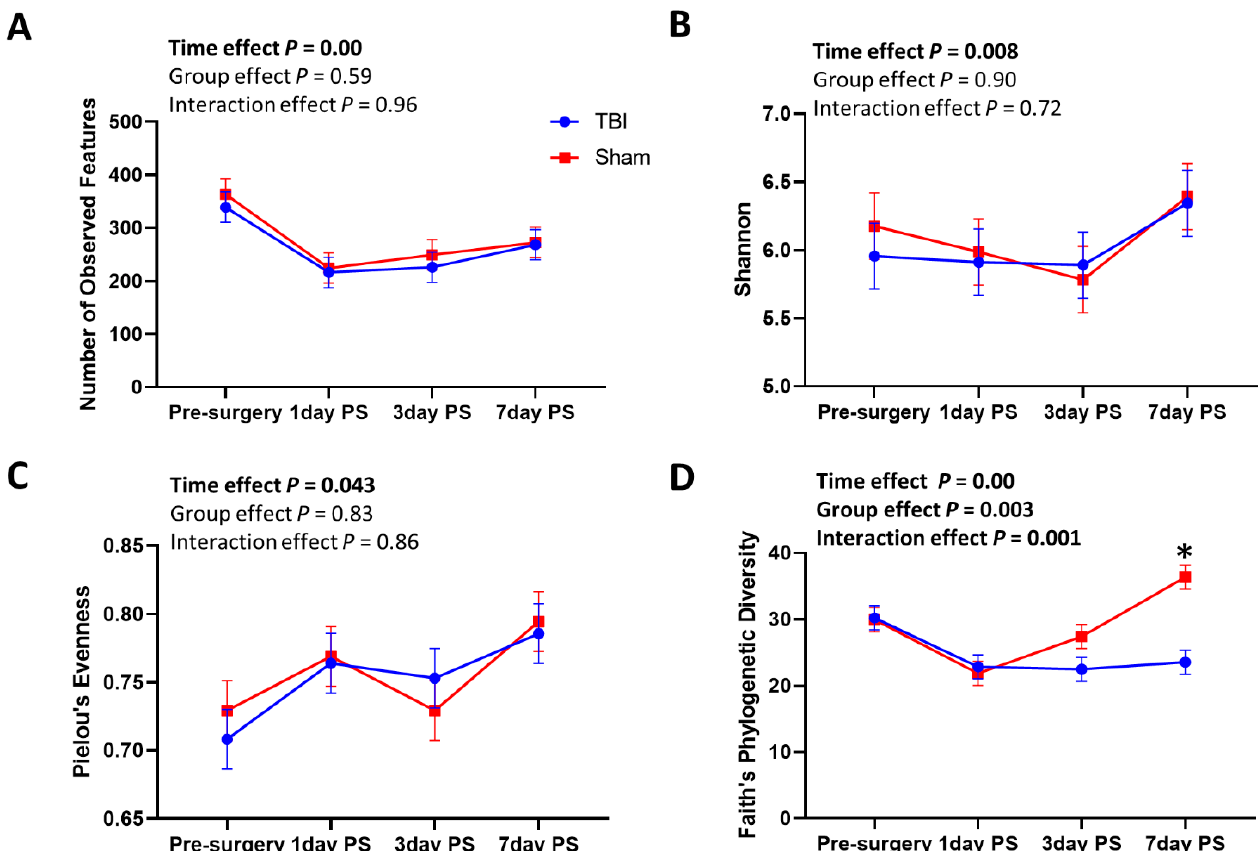
Figure 1. TBI did not significantly alter alpha diversity indexes of the oral microbiome except for Faith’s phylogenetic diversity. Alpha diversity indexes were measured by the number of observed features, Shannon, Pielou’s evenness, and Faith’s phylogenetic diversity. ( A – D ) Significant time effects were found in all alpha diversity indexes, while no group or time-by-group interaction effects were observed except for Faith’s phylogenetic diversity. ( D ) Faith’s phylogenetic diversity was significantly lower in the TBI group ( n = 6) compared to the sham group ( n = 6) at 7 days PS (time, group, and time-by-group interaction effects p < 0.05). *: Time-by-group interaction effect: Tukey post hoc comparison between the TBI and sham groups. PS, post-surgery .